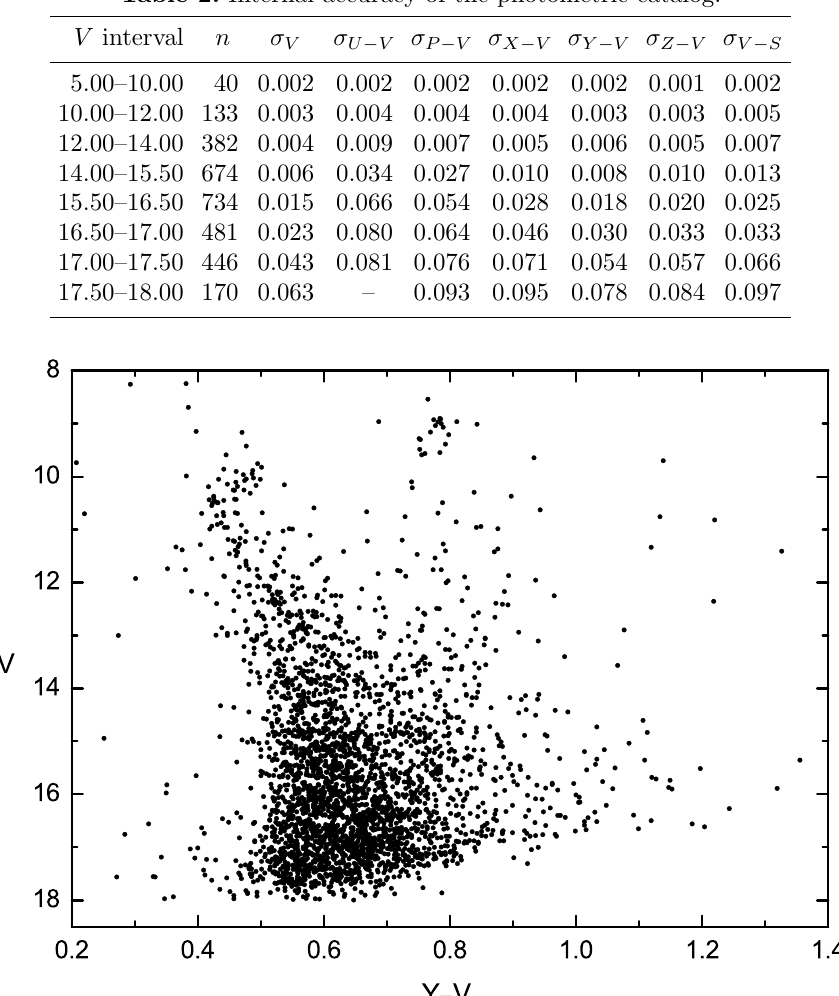
Y V Fig. 2. V vs. Y – V color-magnitude diagram for all stars in the catalog. The V versus Y – V color-magnitude diagram (CMD) for the entire CCD frame for NGC 752 is shown in Figure 2. All data are plotted, irrespective of photometric uncertainty. The cluster main sequence is visible down to ∼ 5 mag below the turnoff point (to nearly V ≈ 16), together with a trace of a sequence of unresolved binaries. At fainter magnitudes, the scatter of points due to photometric errors does not allow to discern the cluster sequence from field